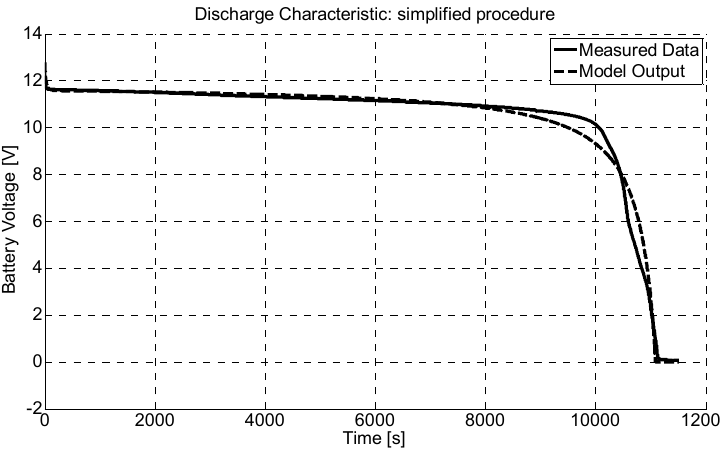
Figure 4. Measured discharge curve and model output with parameters from simplified